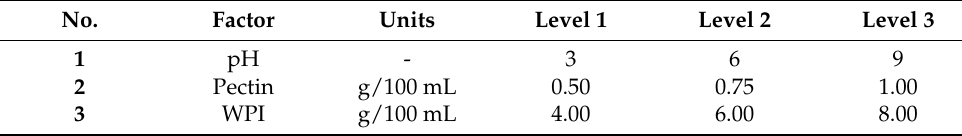
Table 4. Factors and levels considered for the microencapsulation